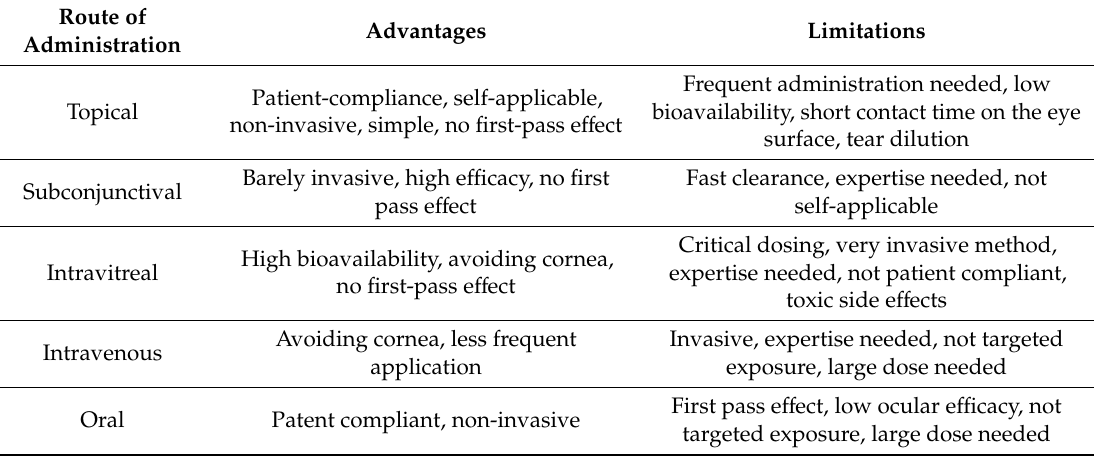
Table 1. Routes of administration to the eye with advantages and